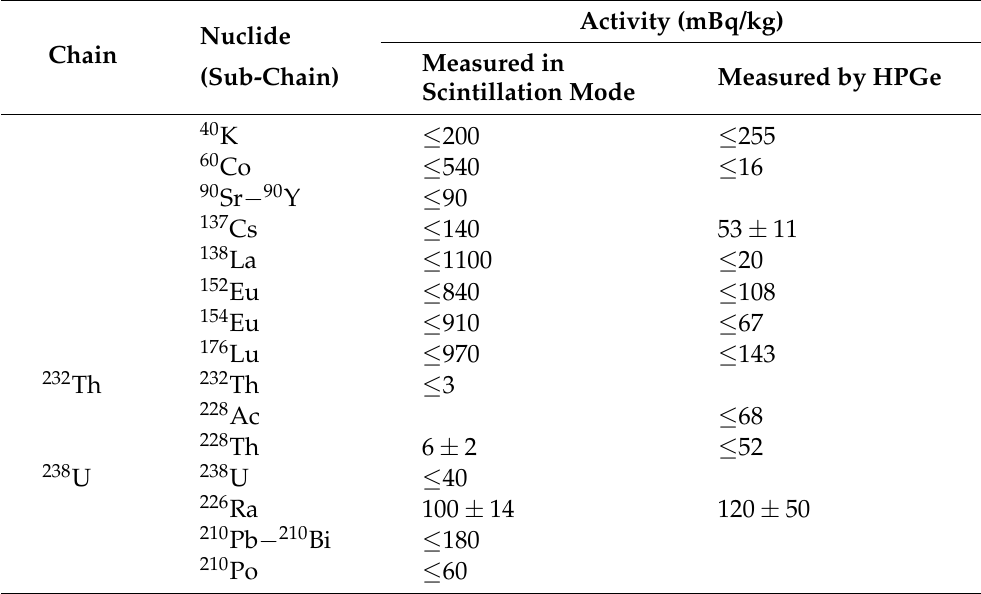
Table 2. Radioactive contamination of the SrI 2 (Eu) scintillator used in Ref. [13]. The upper limits are given at 90% C.L., and the uncertainties of the activities at 68%